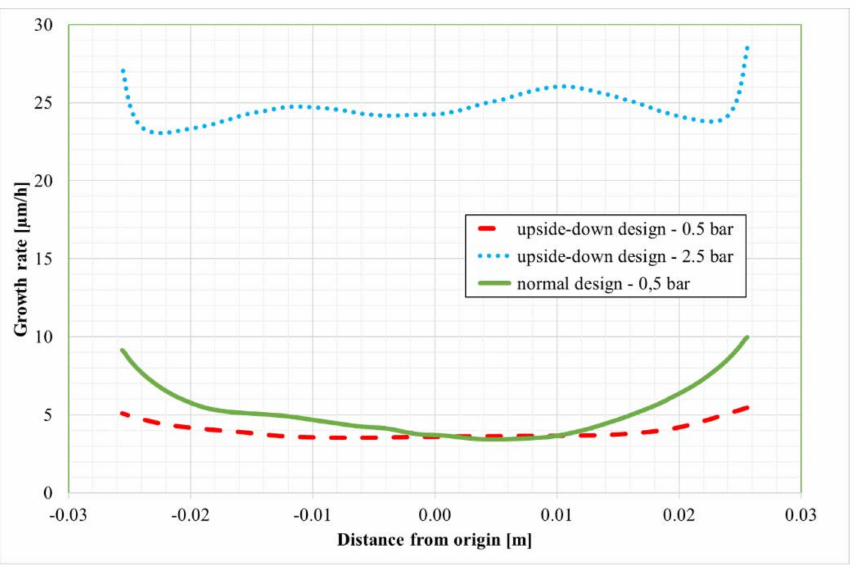
Figure 10. The GaN (gallium nitride) growth rate distribution along the wafer diameter for the three analyzed